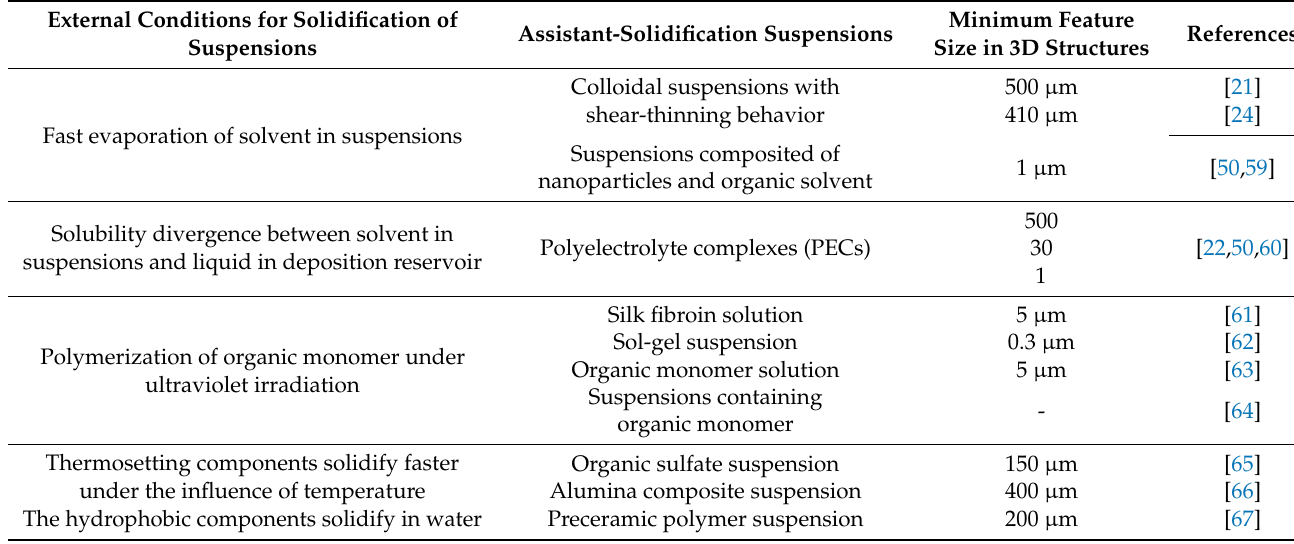
Table 2. Assistant-solidification suspensions designed for direct ink